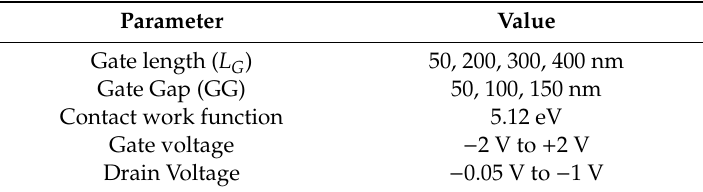
Table 1. Process / device